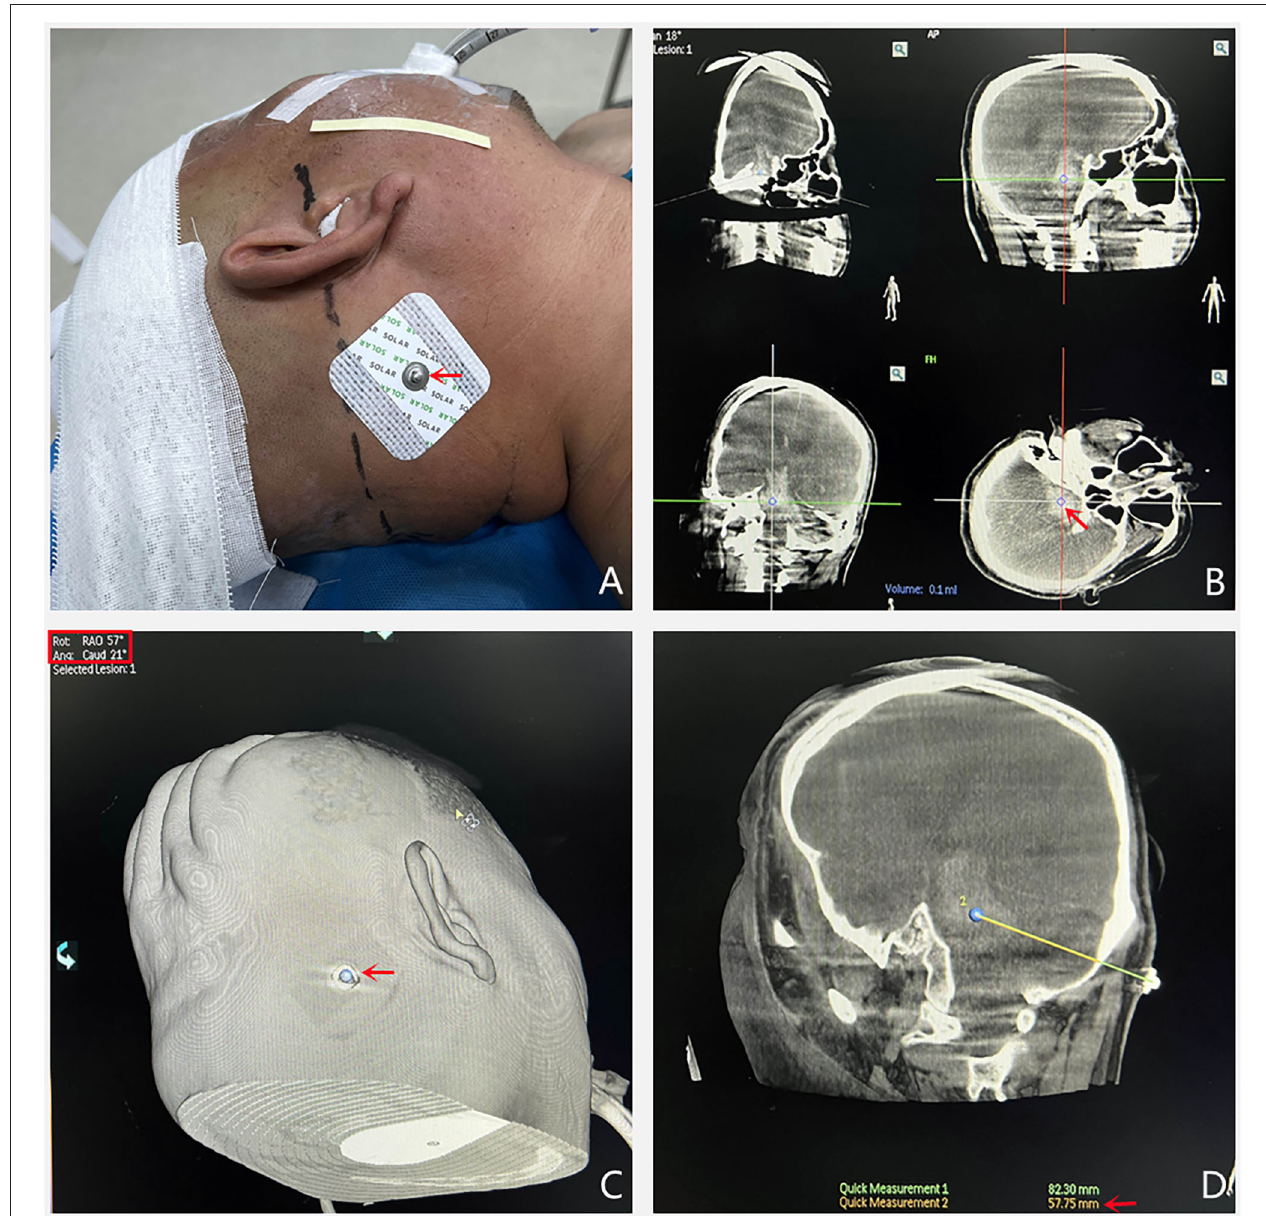
FIGURE 2 | (A) The percutaneous puncture point was marked with electrode pastes. (B) XperCT examination was performed and the center of the largest layer of hematoma was identified as the puncture target. (C) When the percutaneous puncture point and the puncture target are overlapped, the software will display two angles. (D) The puncture direction is the line between the percutaneous puncture point and puncture target. The puncture depth is the distance between the puncture target and the cortical brain